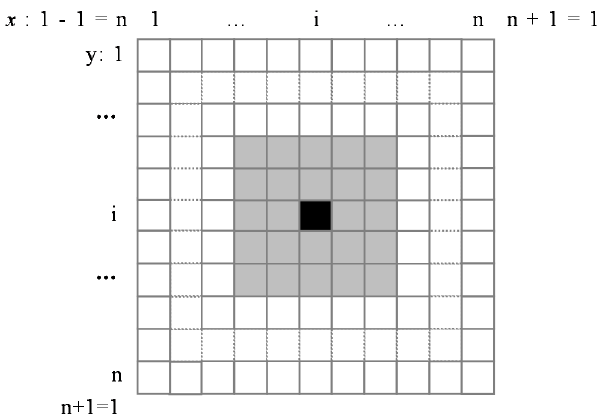
Figure 5. Extended Moor type neighborhood model and boundary conditions. The Black is the central cell and the gray is the neighbor cell. i is a positive integer between 1 and n.